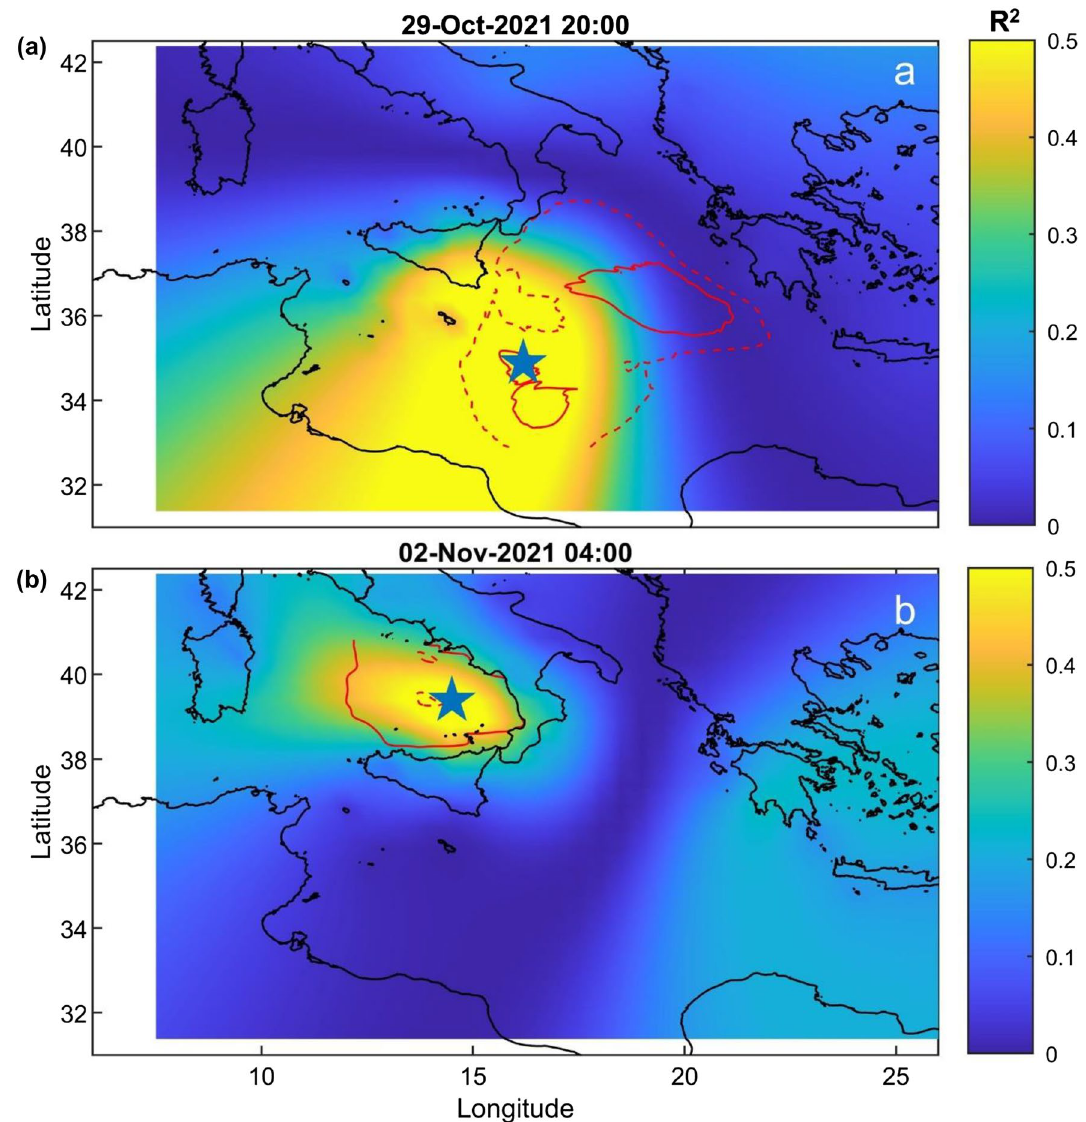
Figure 6. Localization of the microseism source for the period 29 October 2021 20:00 ( a ) and 2 November 2021 04:00 ( b ). The blue five-point star indicates the centroid position of all the grid nodes whose R 2 values do not differ by more than 1% from the maximum R 2 value. The red line represents the significant wave heights (in m) obtained from the Copernicus product MEDSEA_HINDCAST_WAV_006_012. In particular the dotted line represents significant wave heights of 2 m, the dashed line represents significant wave heights of 2.5 m and the solid line represents significant wave heights of 3